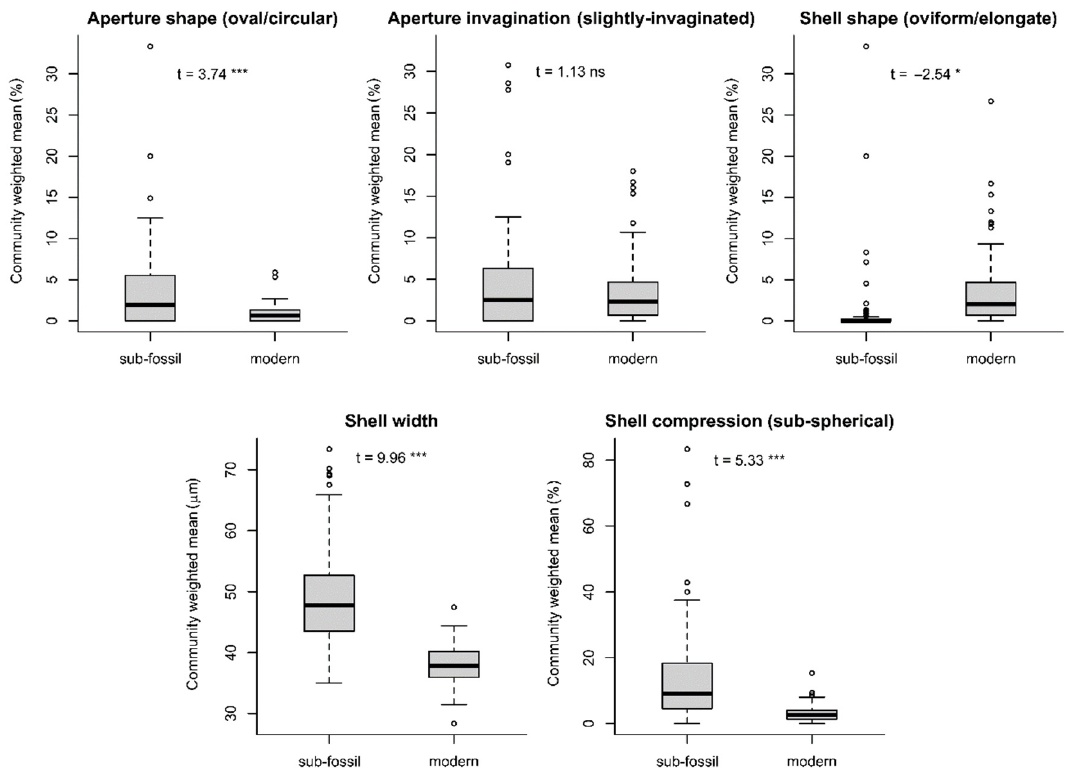
Figure 6. Community-weighted means (CWMs) for the modern (training set) and sub-fossil com- munity of testate amoebae in the Sungai Buluh peatland (Central Sumatra, Indonesia). The results of a two-sample t -test are added to the plots to show significant differences (ns—not significant, *— p < 0.05, ***— p < 0.001).